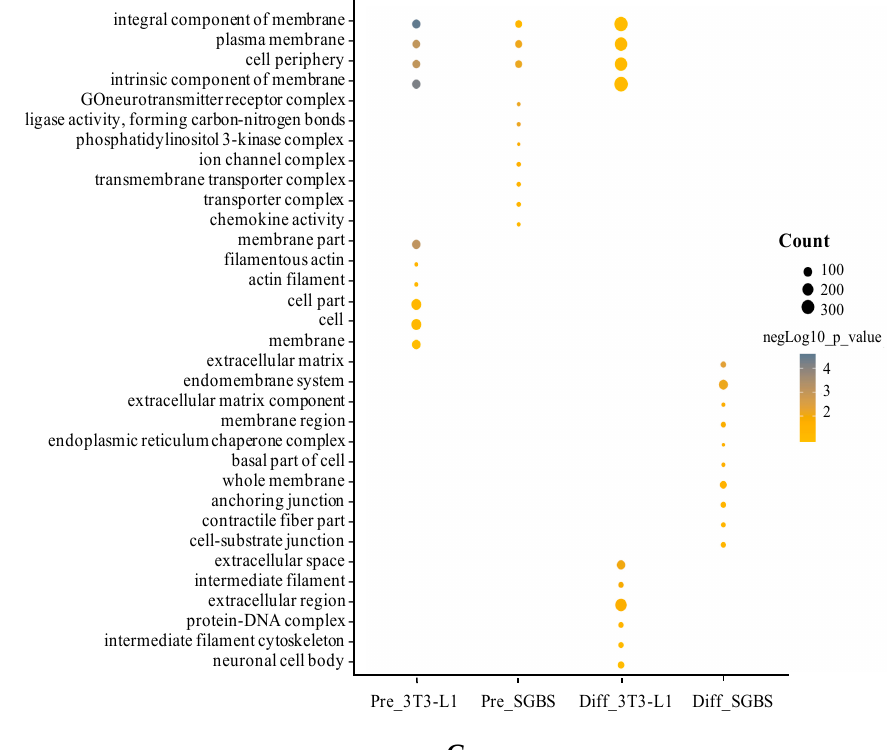
Figure 4. Top 10 enriched GO terms in biological process ( A ), molecular function ( B ), and cellular component ( C ). For each cell type, the DEG list was subjected to GO analysis and the most enriched GO terms were summed up. Size of the bubbles indicates counts of genes identified in each GO term, and colors of the bubbles show significance ( − log 10 p -value) of GO enriched fold changes compared to control.